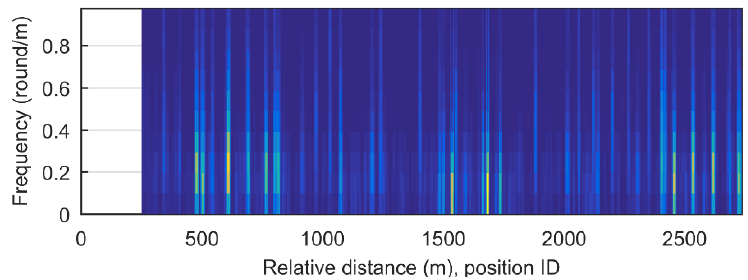
Figure 16. Reference spectrogram (pre-indexed database).